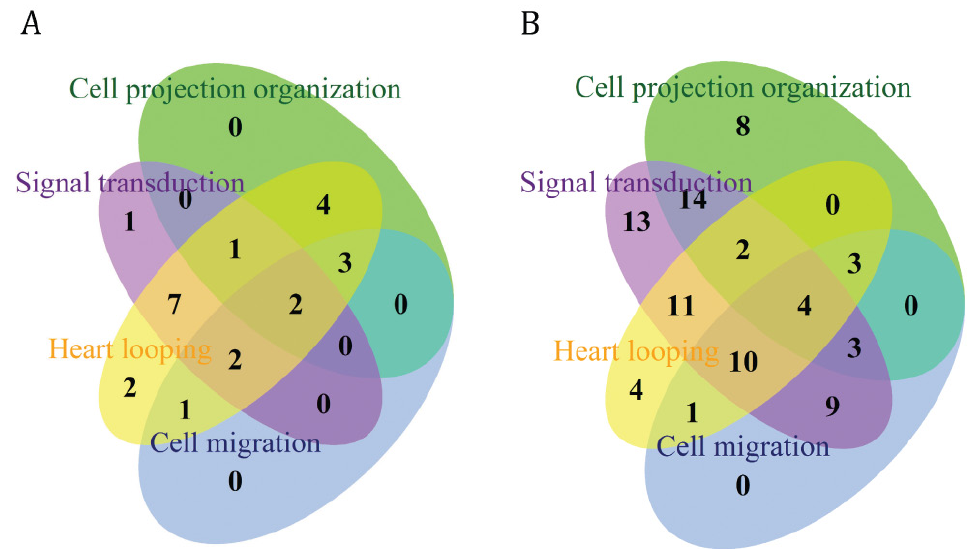
Figure 2. Venn diagrams describing the multiple roles of genes associated with heart development. Venn diagrams showing the overlap between the GO terms associated with A ) the zebrafish ‘heart jogging’ gene list (30 genes) and B ) the mouse combined heart development gene list (103